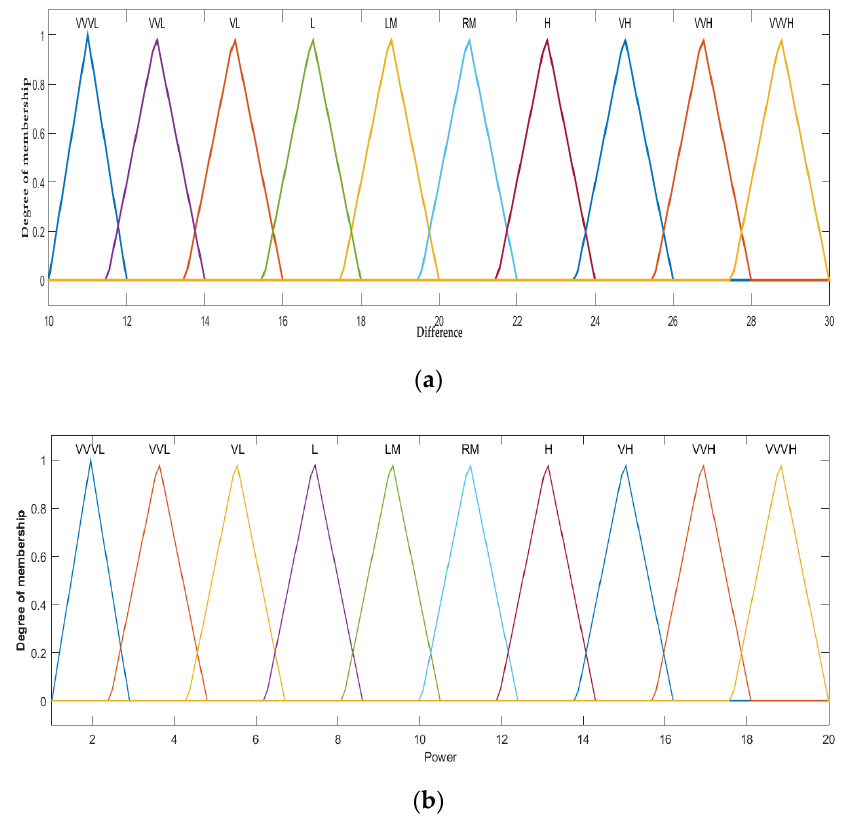
Figure 7. Membership functions for Mamdani fuzzy controller: ( a ) input difference (D) and ( b ) output power (P).